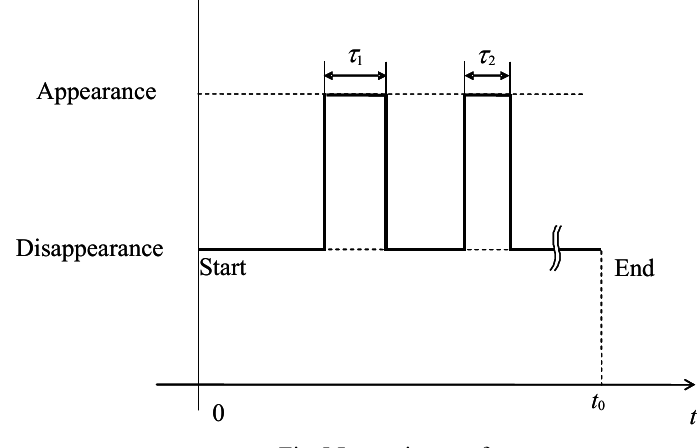
Fig.5 Intermittency factor γ